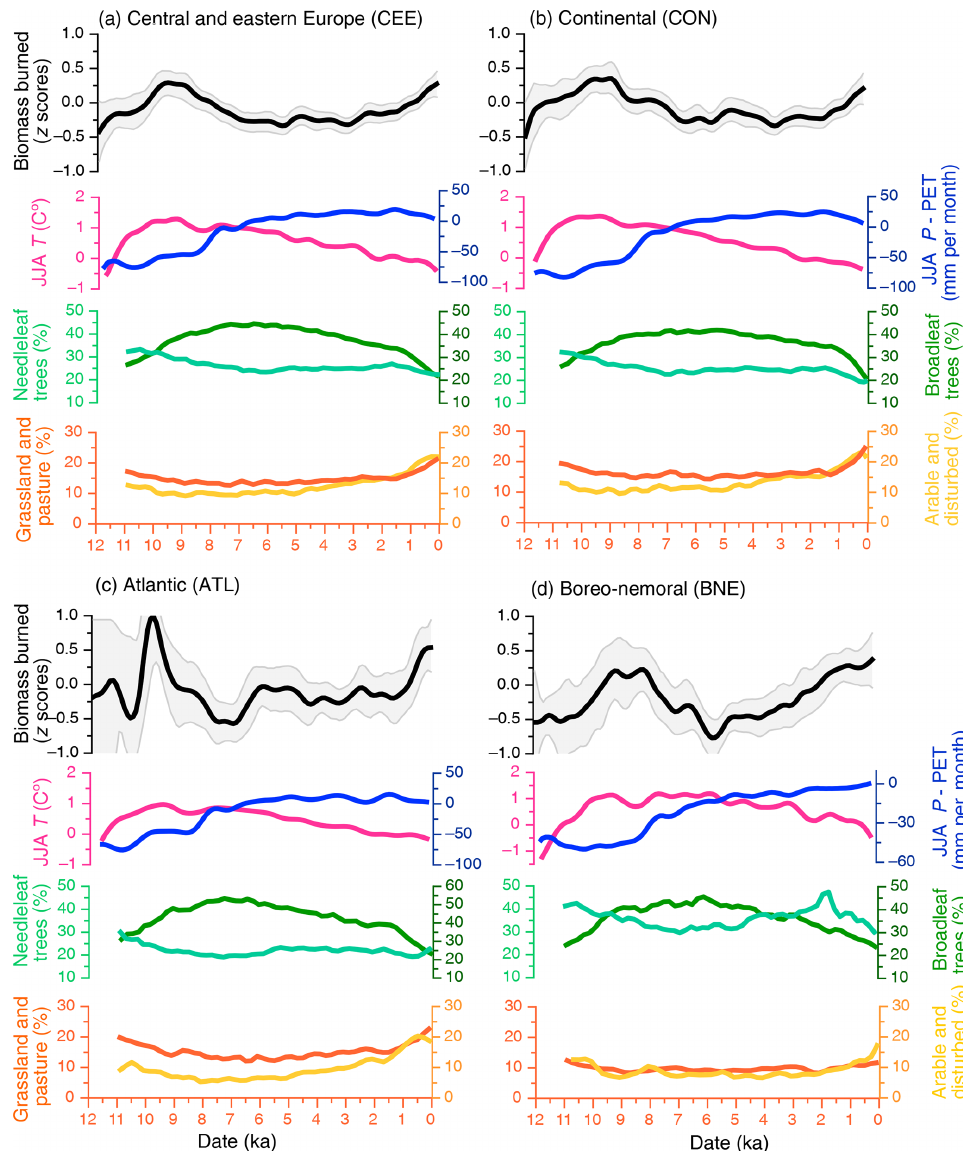
Figure 2. Holocene trends in biomass burning, climate and land cover changes over all of central and eastern Europe (a) and in each of the following ecoregions: continental (b) , Atlantic (c) and boreo-nemoral (d) . Biomass burning is inferred based on charcoal influx ( Z - score values). Climate conditions (anomalies) represent average simulated seasonal summer (June, July, August (JJA)) temperatures ( T ) and precipitation minus potential evapotranspiration ( P − PET), from a global transient climate simulation. Relative abundance of needleleaf forests, broadleaf deciduous forests, grasslands and arable land is represented by their pollen-based percentages in relation to the total land cover (Fyfe et al., 2015). We fitted a 500-year LOESS smoother for JJA P − PET, temperature and land cover classes for each